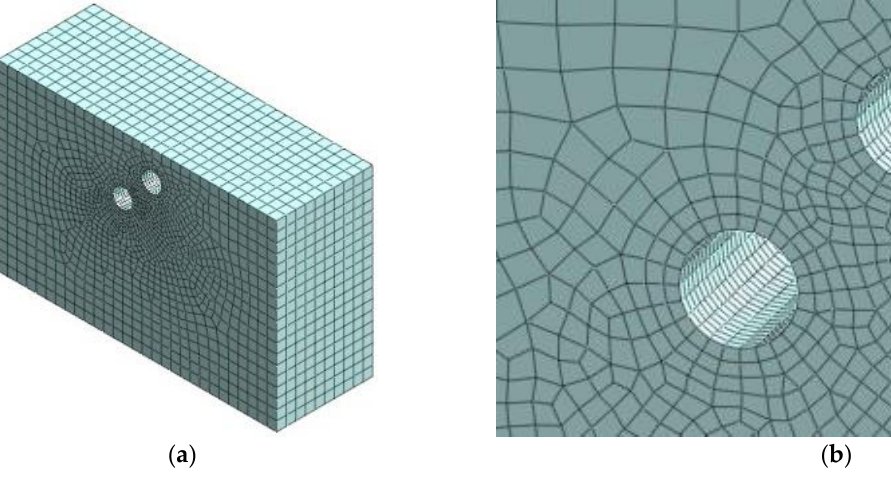
Figure 4. Mesh in the FEM twin tunnel model (ID #1). ( a ) Perspective view of the mesh of the entire model, and ( b ) zoomed view of the mesh around the twin tunnels.